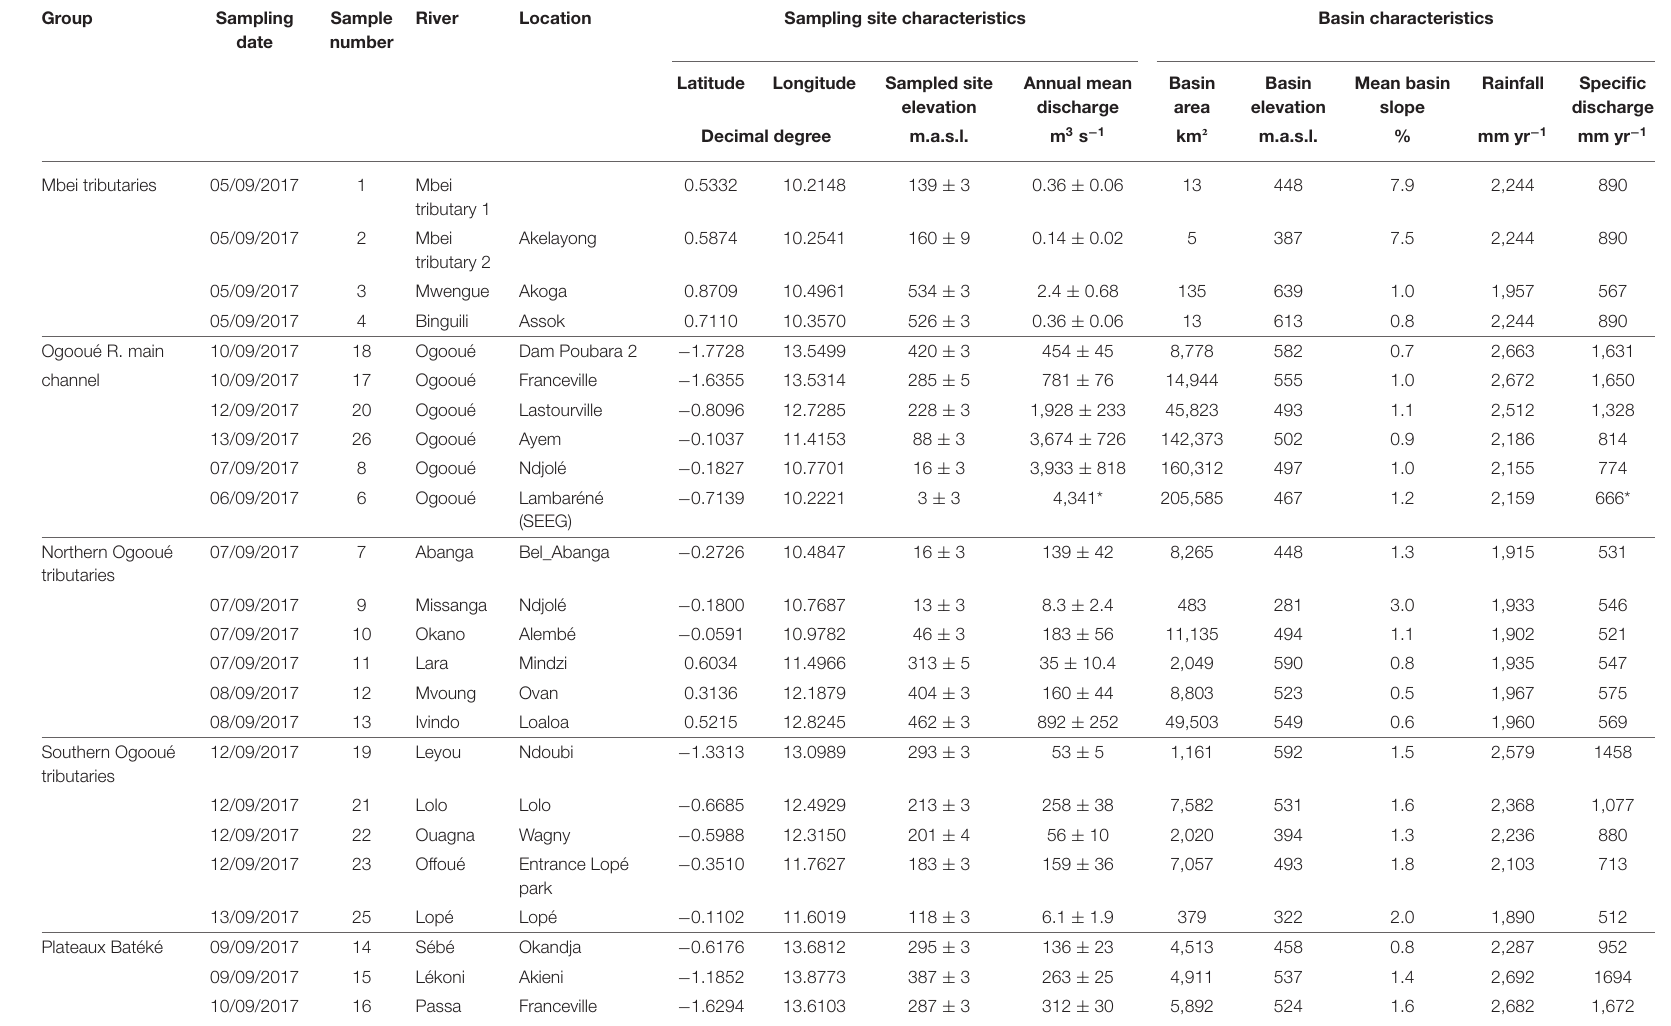
TABLE 1 | Main characteristics of the Mbei and Ogooué rivers and their